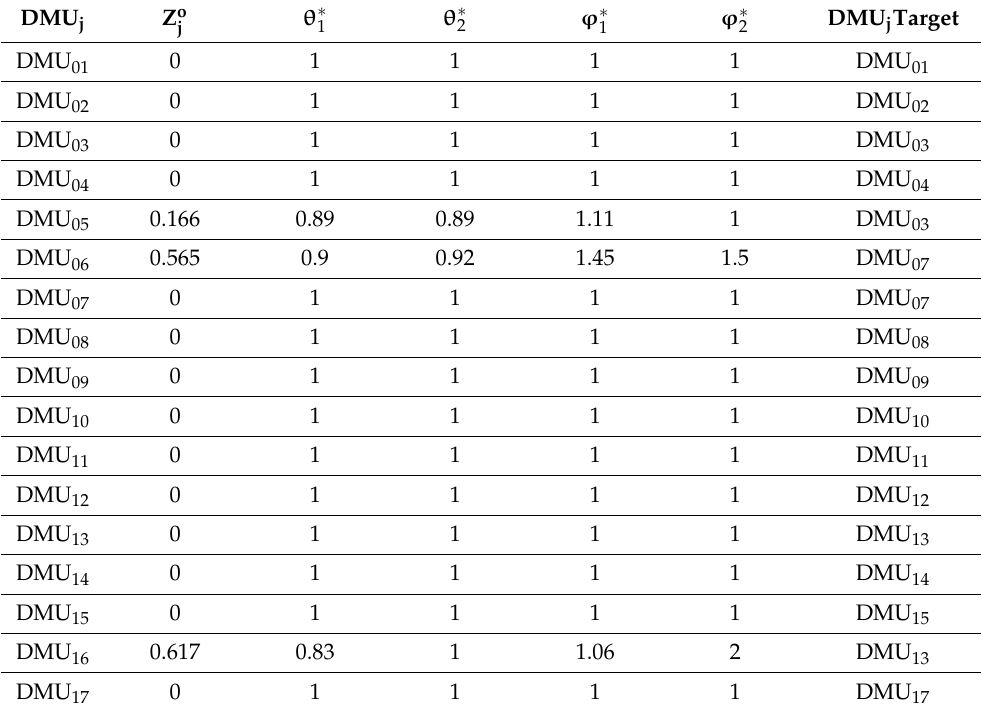
Table 3. The results of solving model 12 (related to the first interactive stage) in the first case study. DMU